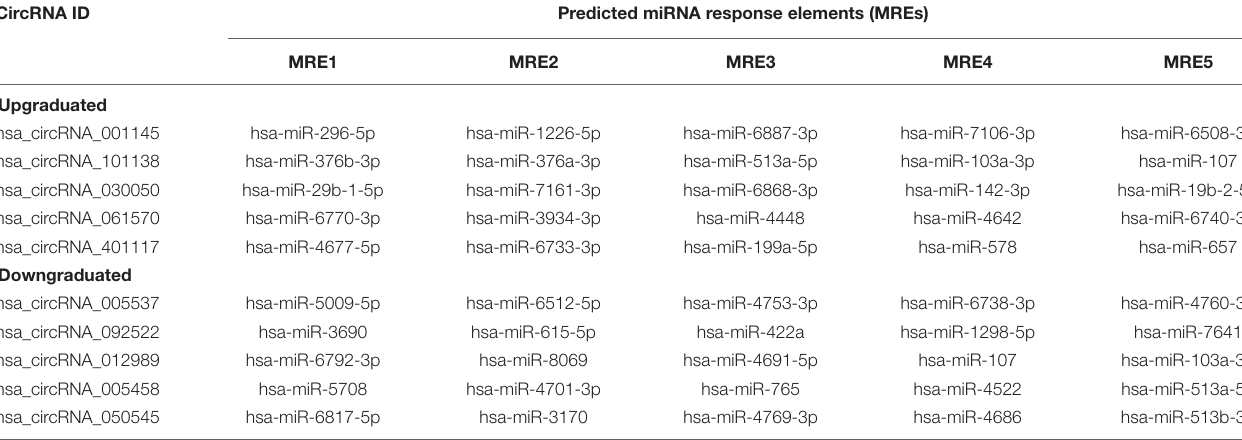
TABLE 4 | Predicted miRNA response elements of top five upregulated and downregulated circRNAs. CircRNA ID Predicted miRNA response elements (MREs)